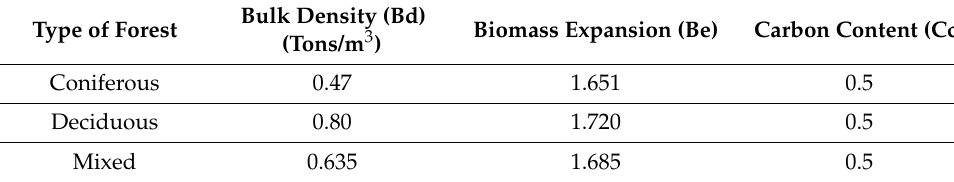
Table 2. Coefficients for calculating carbon sequestration by forest